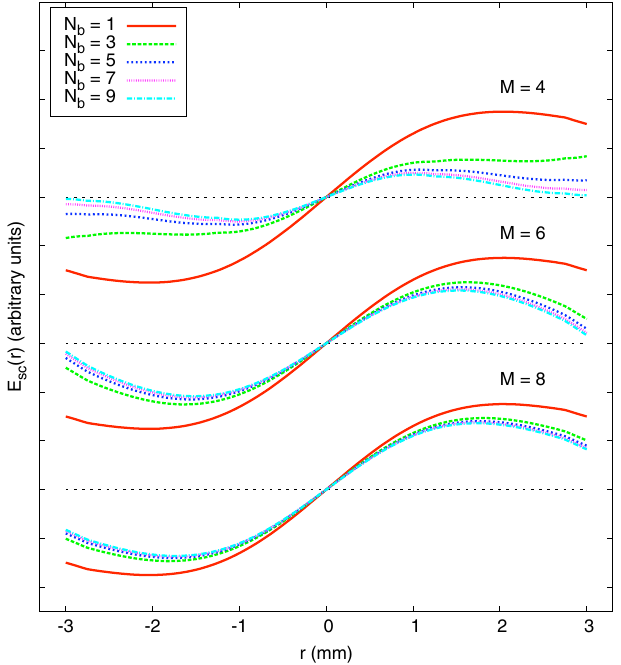
ð r Þ of the mul- sc